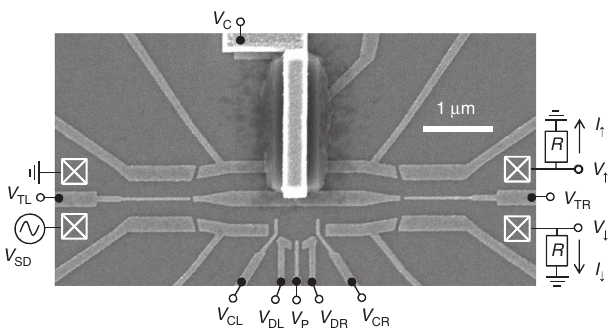
Fig. 6 SEM image of the device and scheme of experimental setup. Ohmic contacts are schematically indicated via crossed boxes. The output currents I ↑ and I ↓ are obtained from the voltages across the resistance, R = 10 k